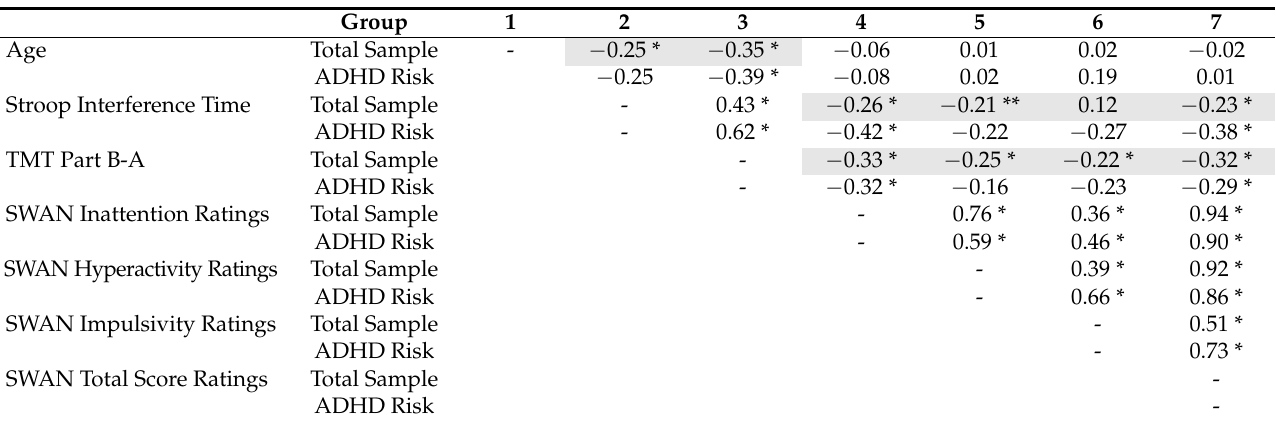
Table 3. Correlations between age, EF tasks and parent reports of impulse and attention regulation among